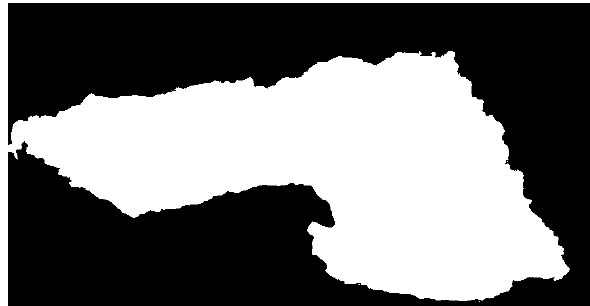
Figure 6. Image binarization for change